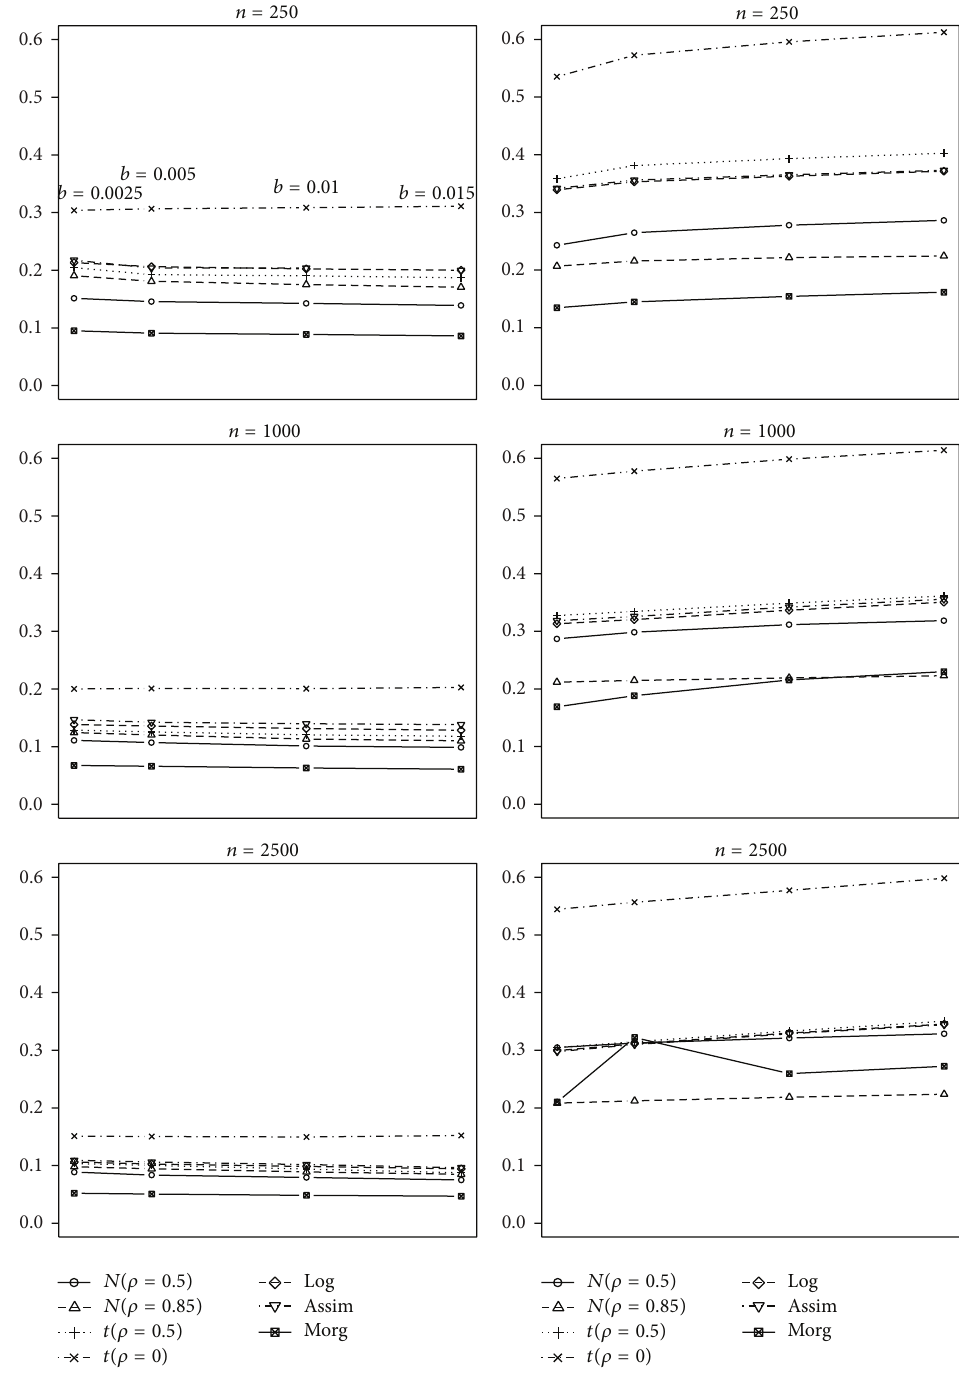
̂𝜒 (b). The four values plotted in each line correspond to 𝑏 =